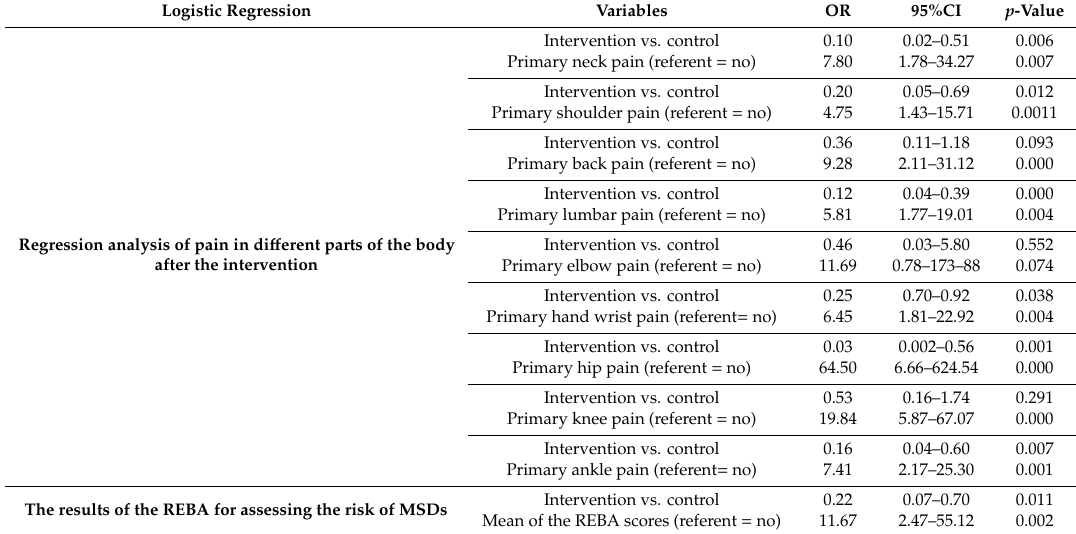
Table 4. The logistic regression analysis of pain in di ff erent parts of the body after the intervention and the results of the rapid entire body assessment (REBA) for assessing the risk of musculoskeletal disorders